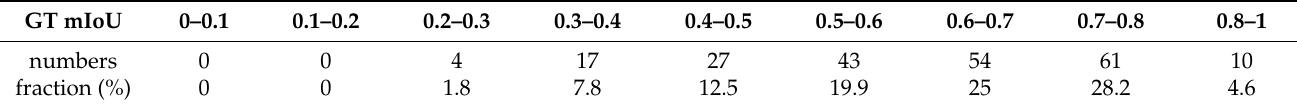
Table 14. HMG testing set—distribution of the ground truth (GT) mean intersection of union (mIoU). GT mIoU